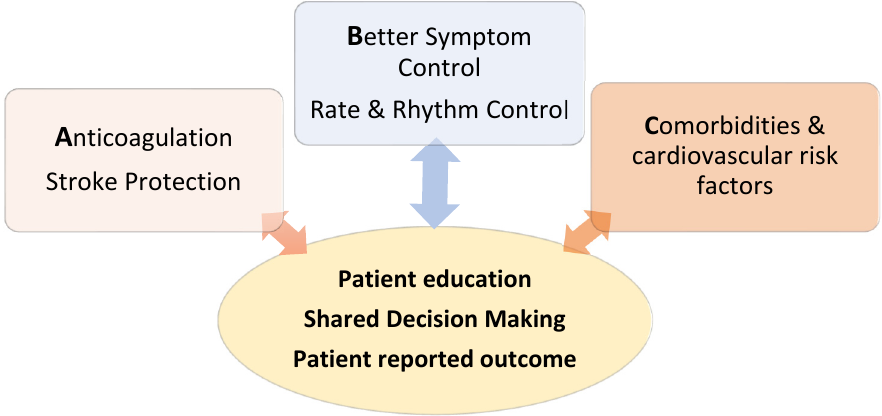
Figure 3. Illustration of the components of the ABC of AF Management in 2020 to ensure effective AF management for each patient. The three treatment pillars should be incorporated in an integrated care concept, which has patient education, shared decision making and patient reported outcome at its core.